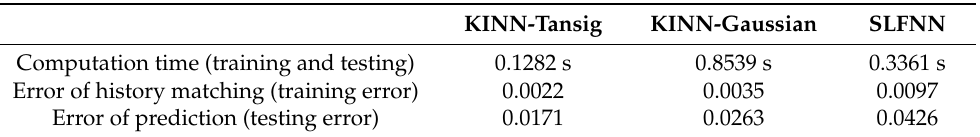
Table 6. The time consumption, training error (MSE), and testing error (MSE) of KINN-tansig, KINN-Gaussian, and SLFNN in the Egg reservoir case.